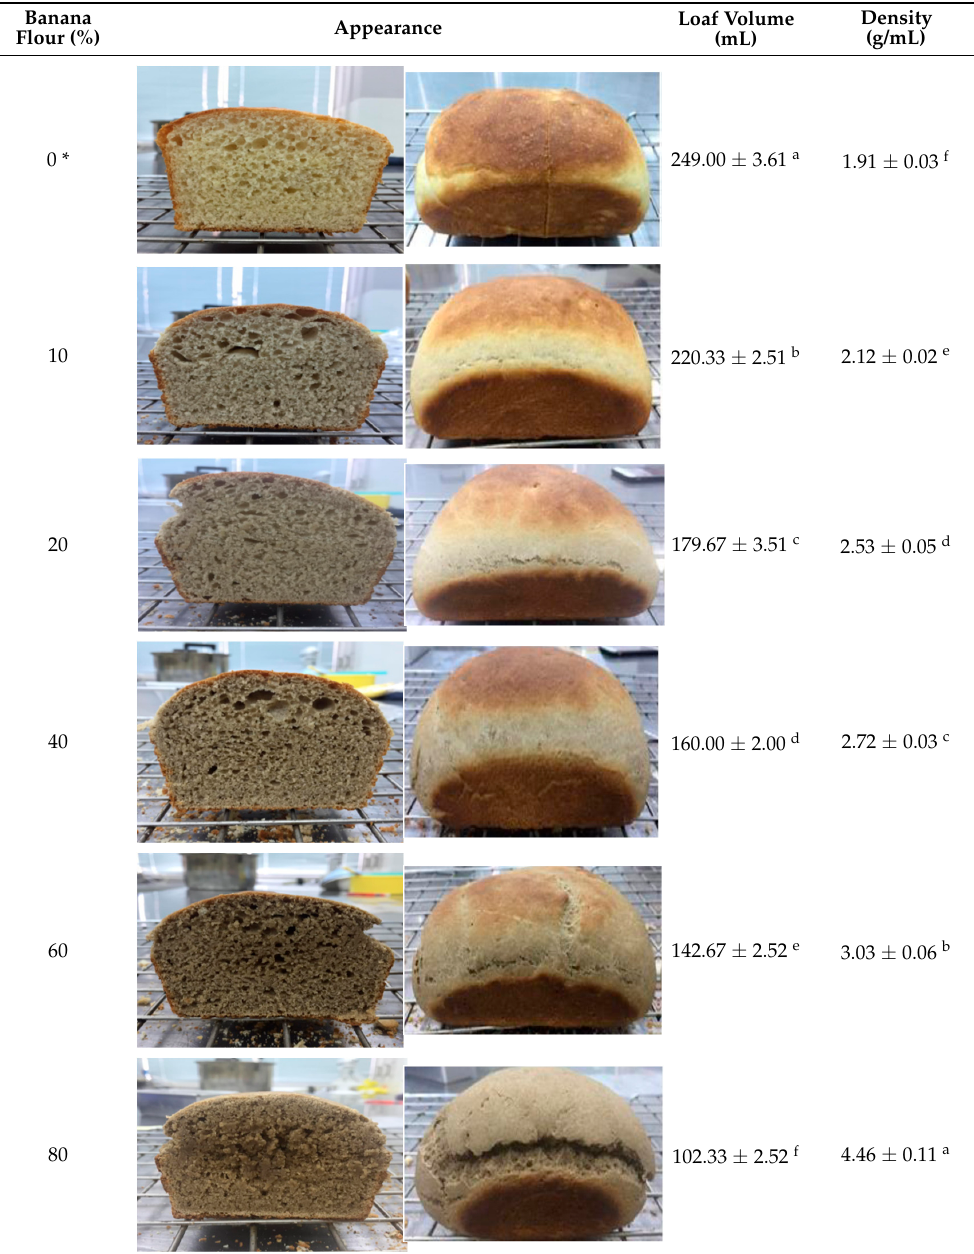
Table 3. Appearance, loaf volume, and density of breads with different amounts of unripe banana flour.